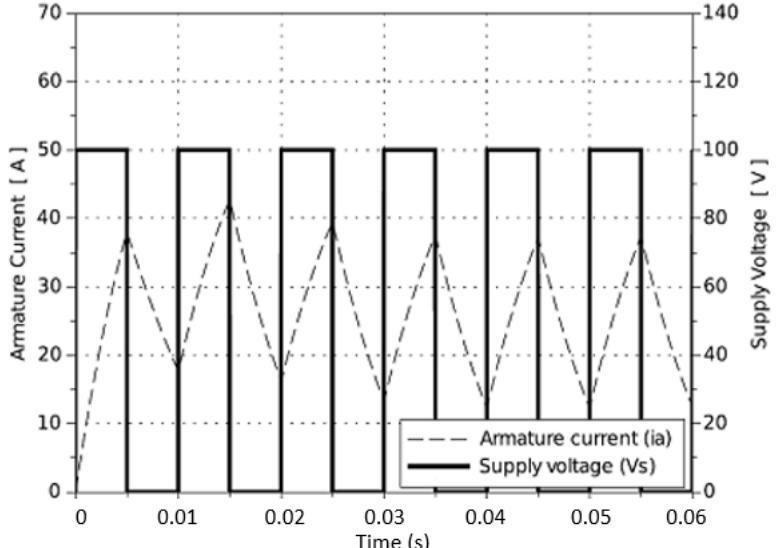
Figure 11. Simulation (Scilab) under no-load conditions, with a PMW supply voltage of amplitude equal to 100 V and a duty cycle of 50%. The dependent variable is i a ( t )